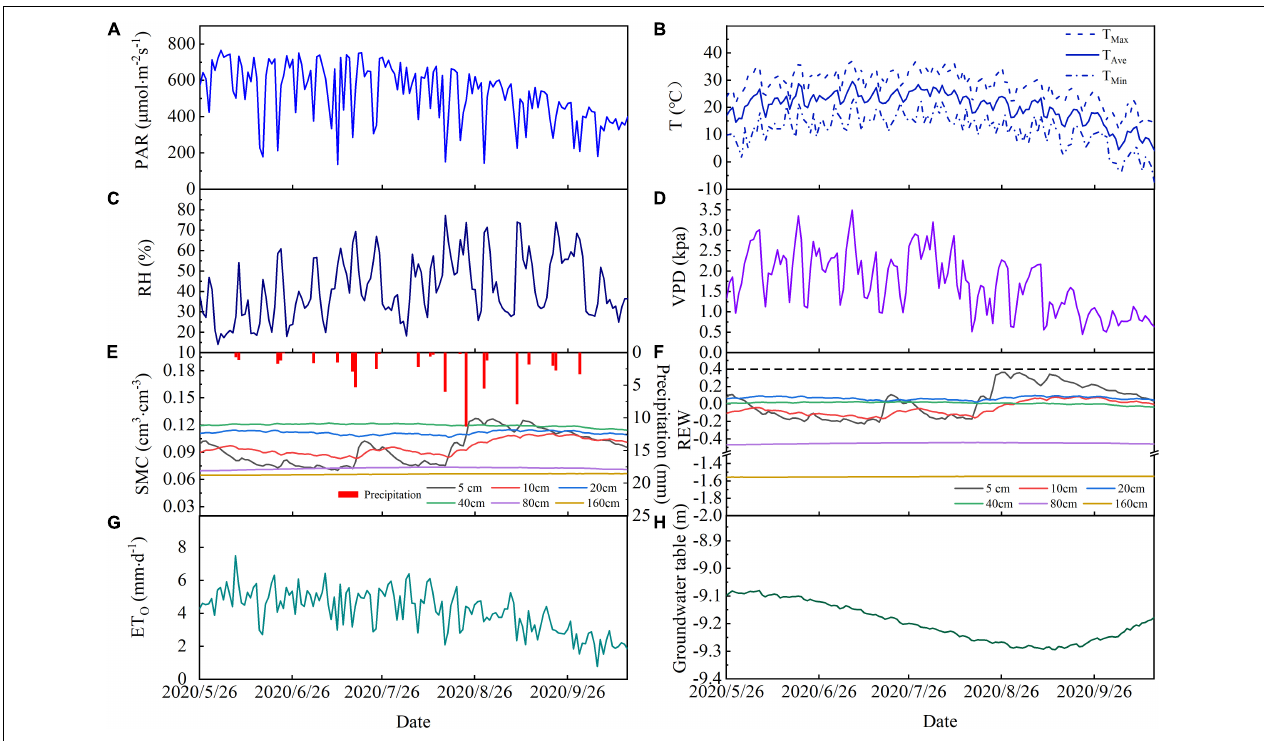
FIGURE 2 | Temporal variations in (A) photosynthetically active radiation (PAR), (B) average air temperature (Ta Ave ), maximum air temperature (Ta Max ), and minimum air temperature